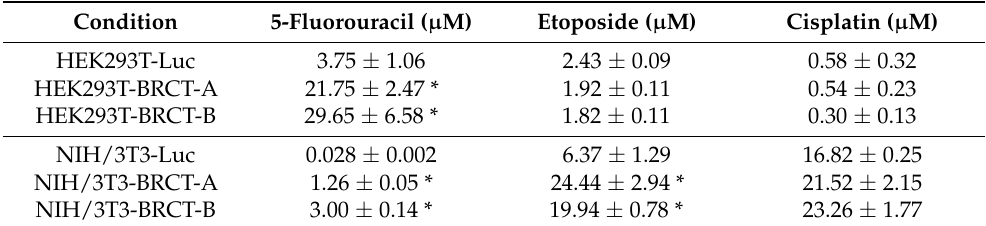
Mean ± SD, * p < 0.05 vs.